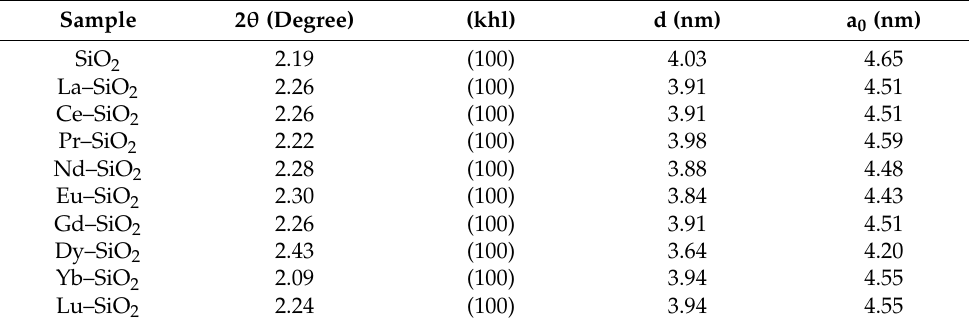
Table 2. Data obtained from X-ray diffration for calcined SiO 2 and Ln–SiO 2 .